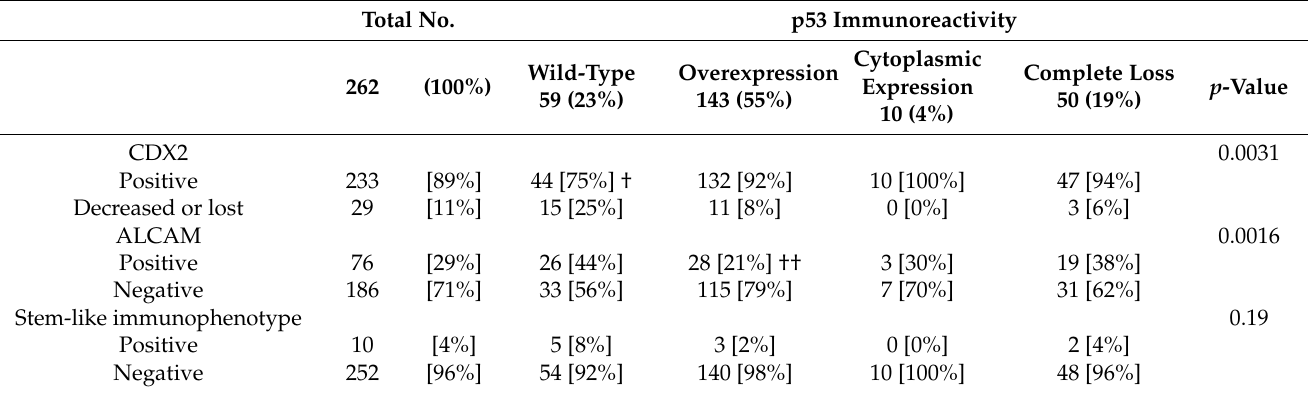
Table 2. Association between p53 immunoreactivity and stem-like features.